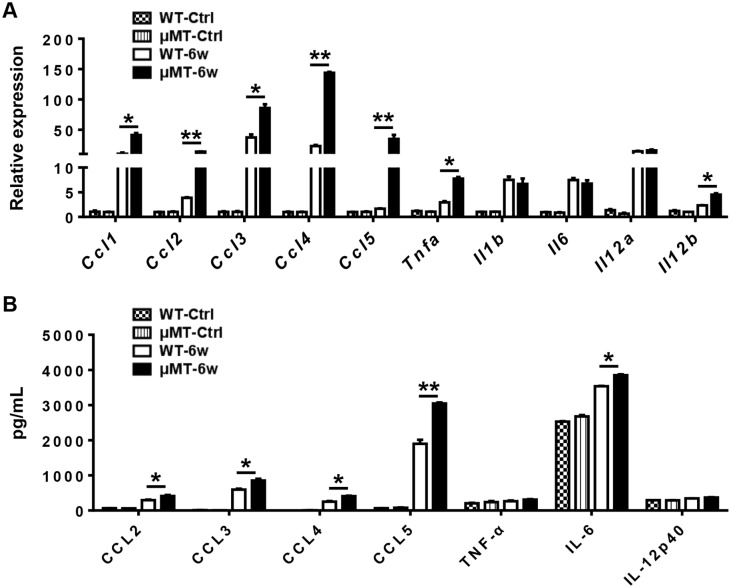
Inflammatory cytokines and chemokines are increased in the liver of μMT mice after S. japonicum infection.(A) Relative gene expression of chemokines (Ccl1, Ccl2, Ccl3, Ccl4, and Ccl5) and inflammatory cytokines (Tnfa, Il1b, Il6, Il10, Il12a, and Il12b) in the livers of WT mice and μMT mice uninfected and 6 weeks after infection. Genes were normalized to the housekeeping gene Actb as an internal control. (B) Protein levels of CCL2, CCL3, CCL4, CCL5, TNF-α, IL-6, and IL-12p40 in the livers of WT mice and μMT mice uninfected and 6 weeks after infection. Data represent mean ± SD; n = 8–10 mice per group from two independent experiments. *p < 0.05, **p < 0.01.